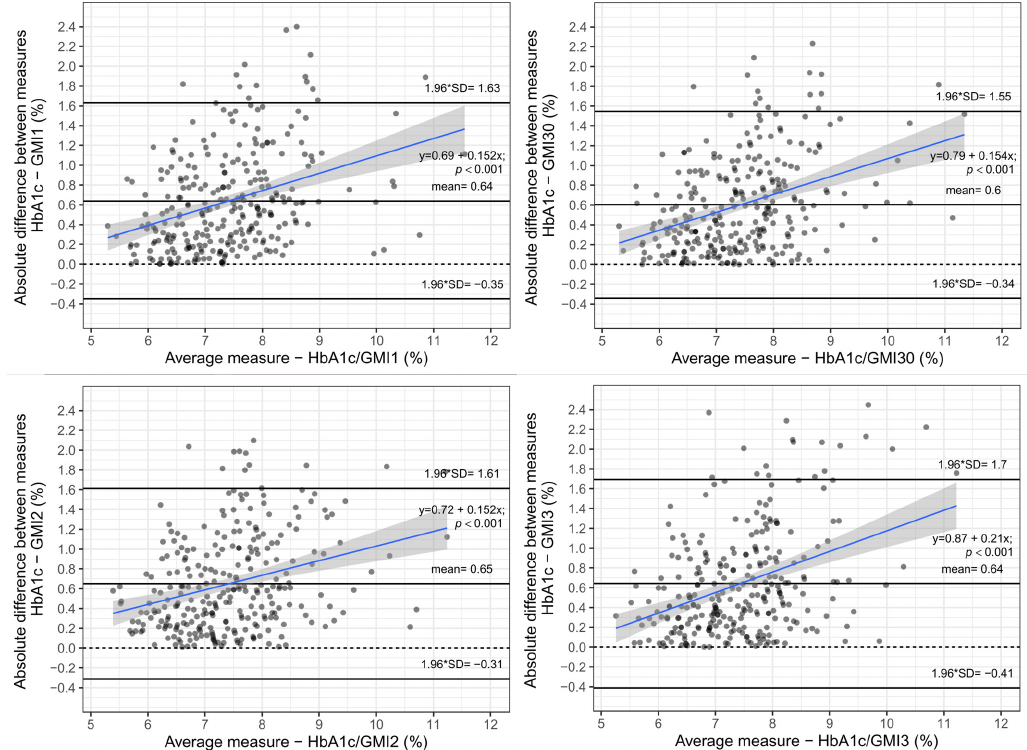
Figure 3. Bland–Altman plot—Absolute value of difference between HbA1c and GMI measurements vs. average of two measurements.